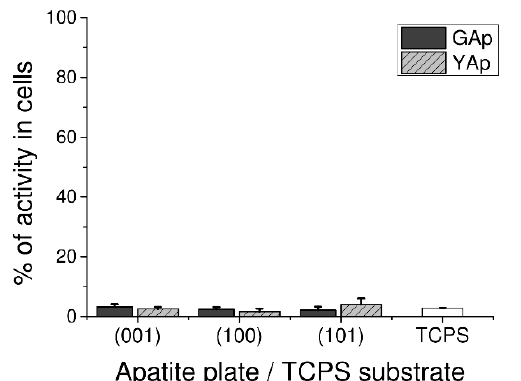
Figure 2. Cytotoxicity in human fibroblasts cultured on GAp and YAp apatite surfaces compared with TCPS substratum (control) and calculated after 48 h of incubation as the percentage of seeded cells. The cytotoxic scale is as follows: zero corresponds to non-toxicity, and 100% means the total leakage of LDH from cells (maximal toxicity). The density of seeded cells was 1 × 10 5 cells/mL in 200 µL of medium. No significant differences exist between groups at p < 0.05 compared with each other and TCPS control.